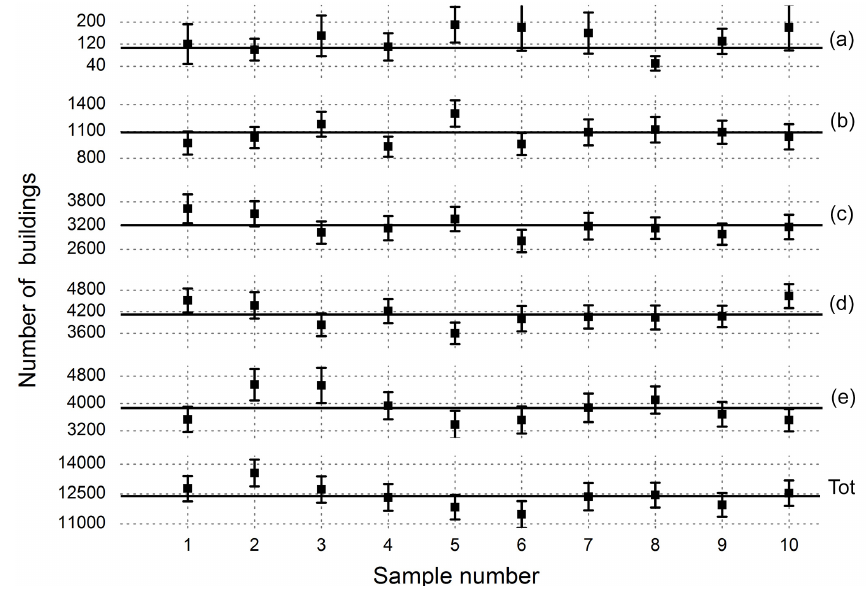
Figure A1. Number of buildings for each building type from A to E and total number of buildings for each of the 10 random, independent samples of cells (each containing 243 cells). The horizontal lines in each subplot correspond to the value reported in Table 5 and refer to the full set of 2433 cells.